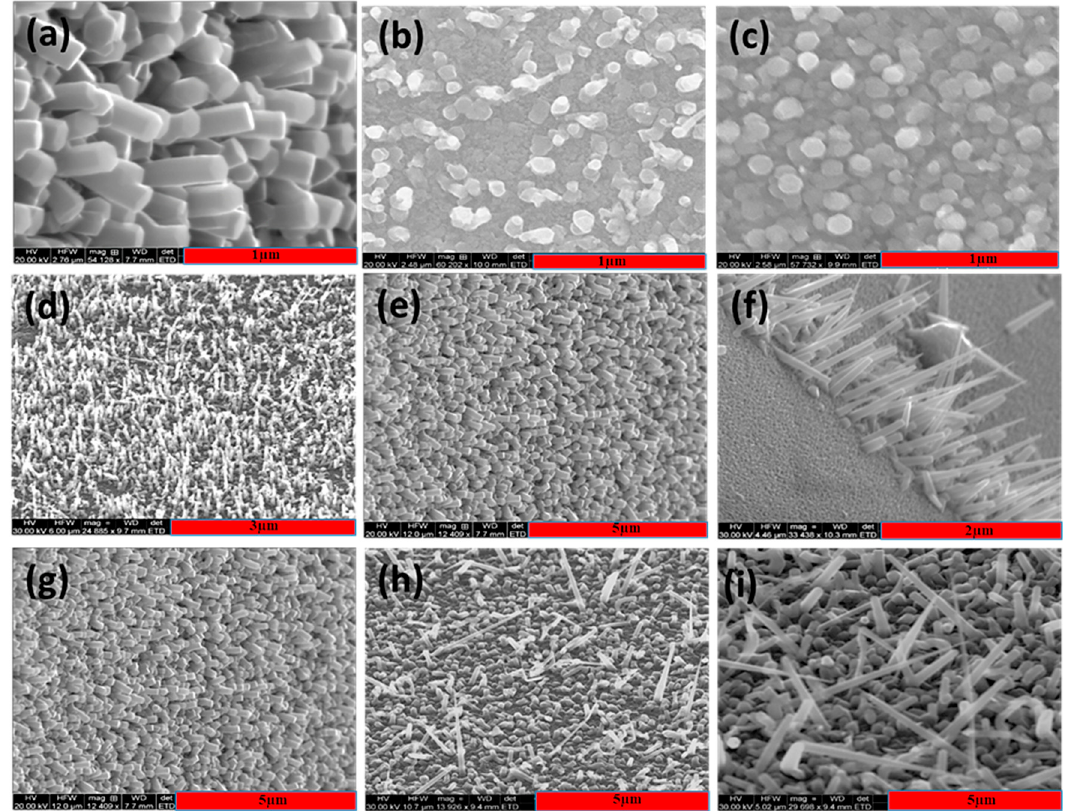
Figure 1. SEM Images of ZnO nanorods ( a ) Vertically aligned on silicon substrate (60 ◦ titled view); ( b ) Sapphire substrate (top view); ( c ) Indium tin oxide (ITO) substrate (top view), SEM images of vertically aligned ZnO nano rods (5000 shots) grown at different temperatures on silicon substrate (60 ◦ titled view) ( d ) 500 ◦ C, ( e ) 550 ◦ C, ( f ) 600 ◦ C and SEM images of the ZnO nanorods by varying the number of pulsed laser shots at 550 ◦ C temperature ( g ) 5000, ( h ) 10,000, and ( i ) Table 1. Average diameter and lengths of VAZO nanorods grown by PLD technique.